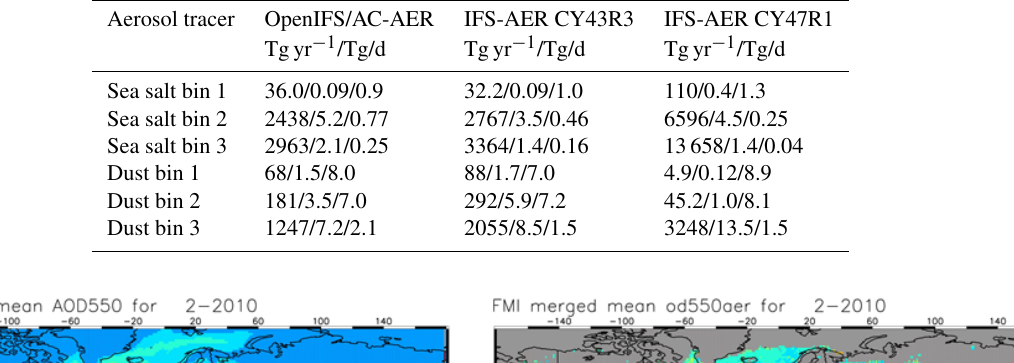
Table 7. Yearly dust and dry sea salt emissions (Tgyr − 1 ), burden (Tg), and lifetime (d), respectively, as simulated by OpenIFS/AC-AER and two versions of IFS-AER. Note that both IFS-AER configurations use a higher resolution ( T L 511/137 levels).